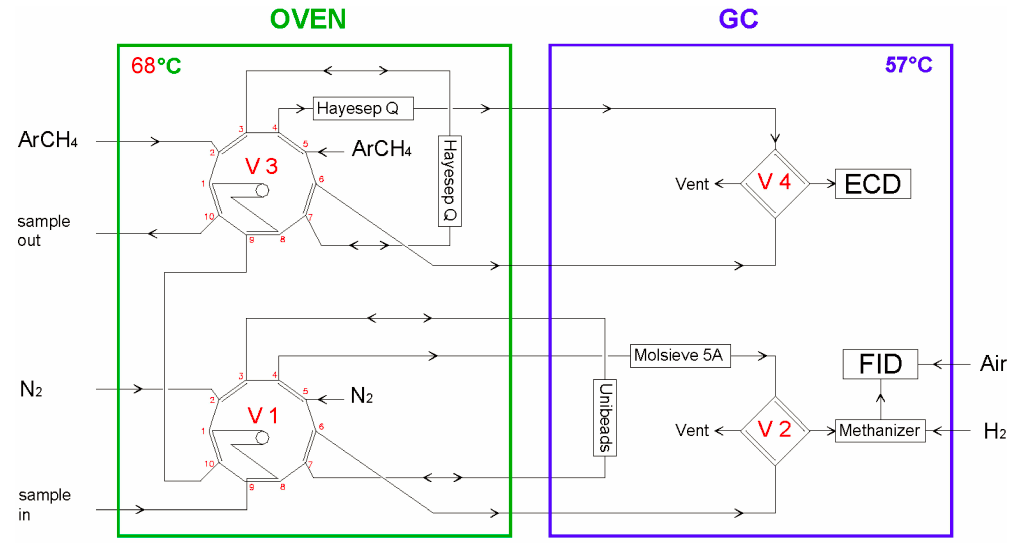
Fig. 6. Layout of the GC measurements system at Cabauw in period C2 since April 2009. For further description see